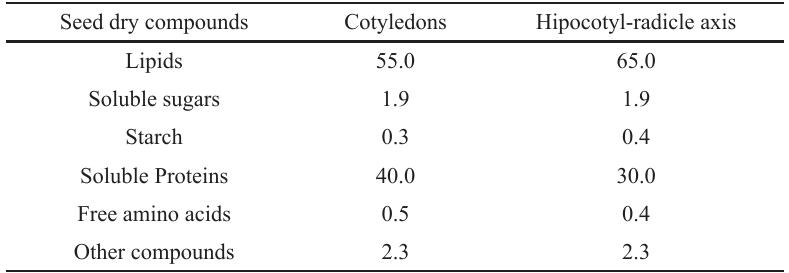
Percentage composition (%) of cotyledons and hypocotyl-radicle axis in Cereus jamacaru dry seeds. Mean values (n=4).